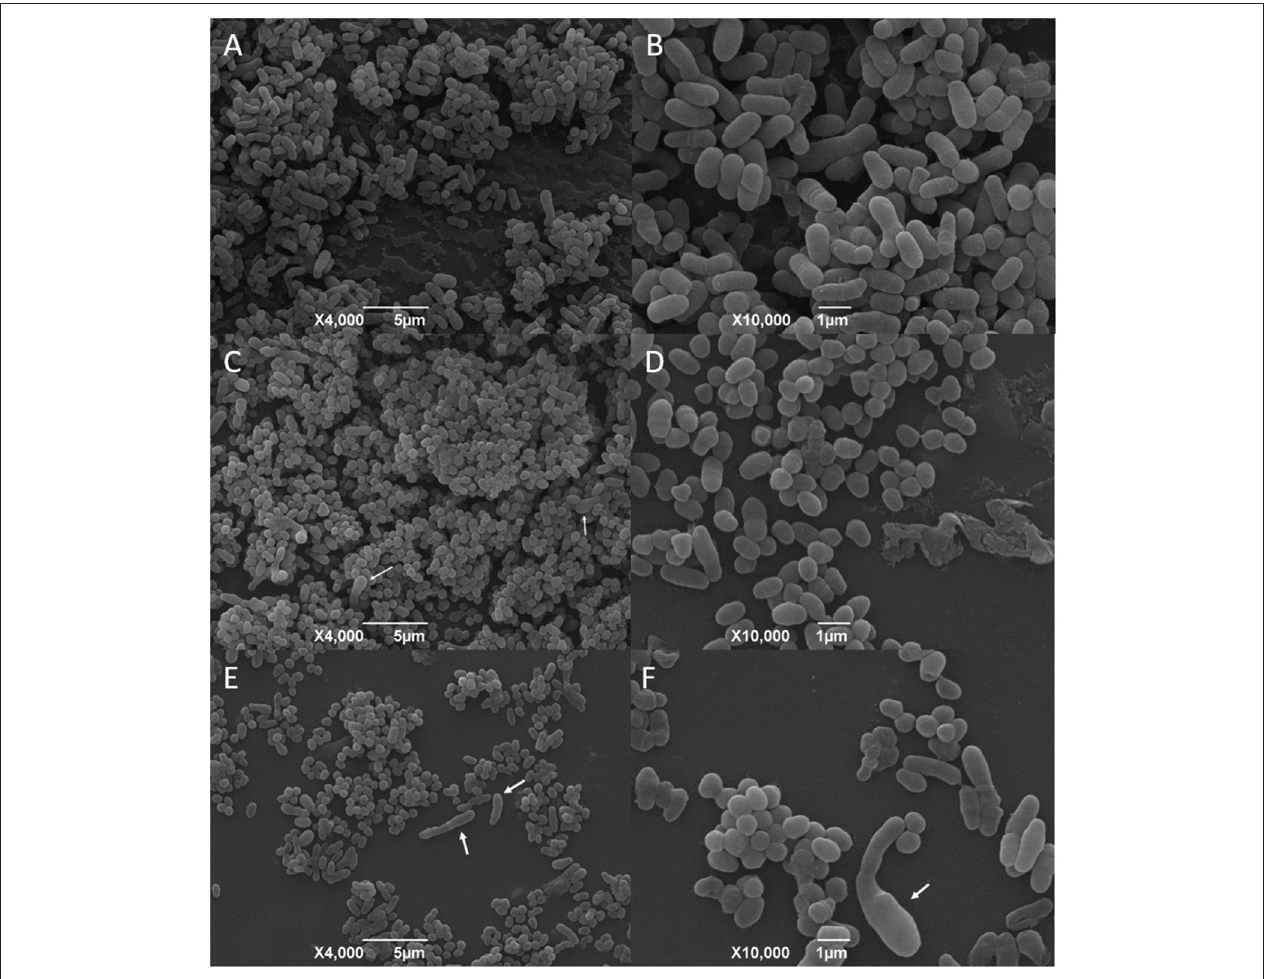
FIGURE 6 | SEM analysis of C. pseudotuberculosis biofilm treated or not with ethanolic green propolis extract. (A,B) represent the bacterial biofilm without any treatment, and (C–F) show the biofilms treated with the green propolis ethanolic extract. The white arrows indicate cellular deformities not seen in the planktonic bacterial cells and in the not-treated